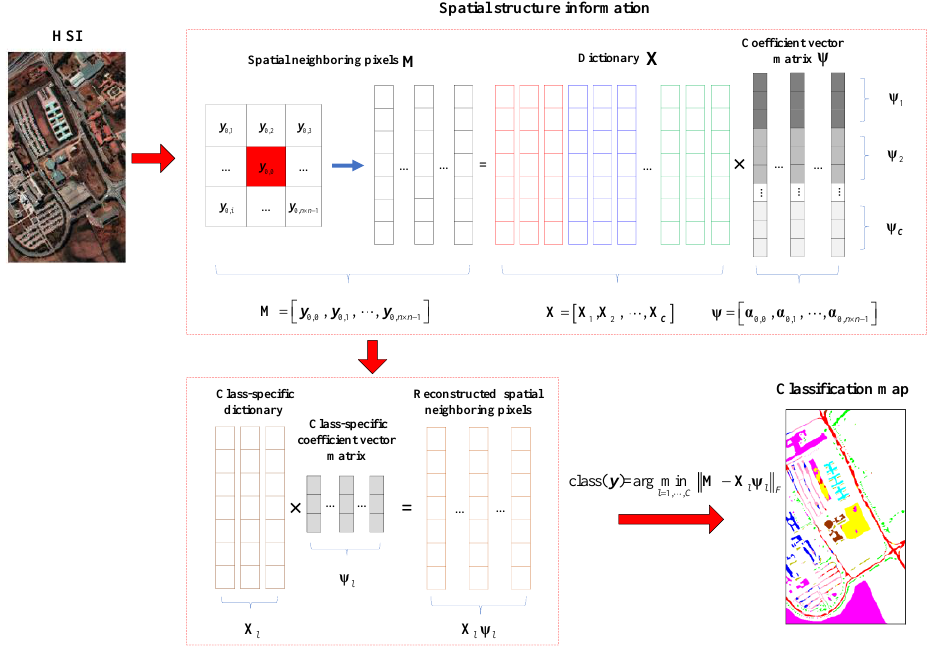
Figure 2. The flowchart for the JCRC method .